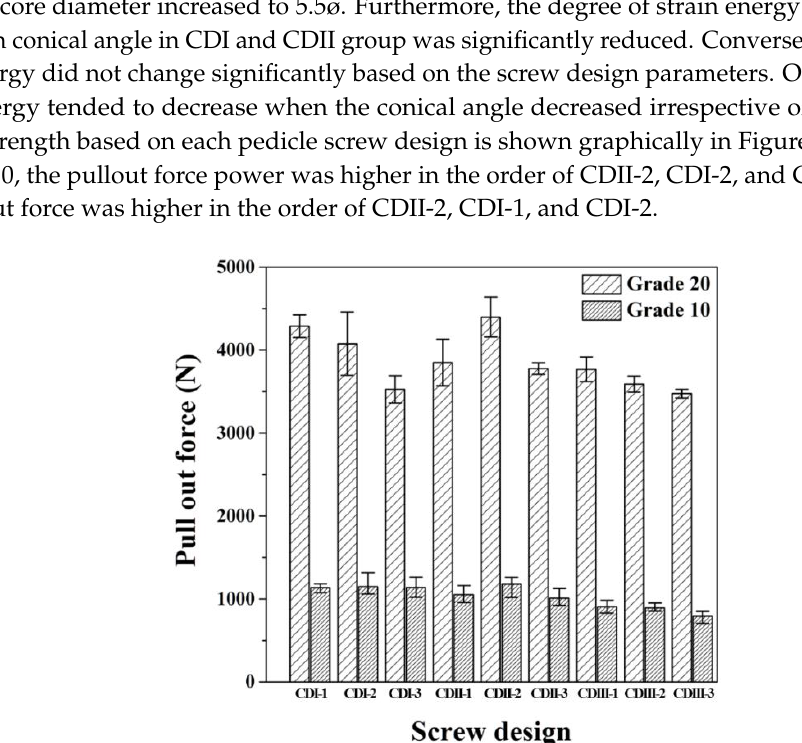
Figure 6. Comparison of ( a ) pullout stiffness and ( b ) pullout strain energy with variables of density and pedicle screw design.